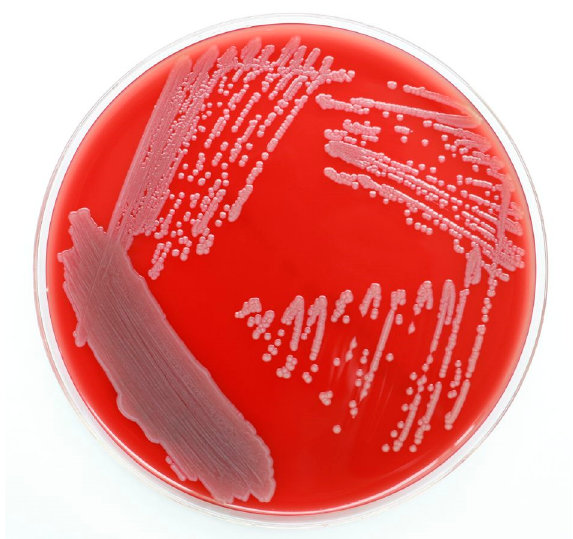
Figure 1. Elizabethkingia meningoseptica on sheep blood agar after 48 h of incubation.